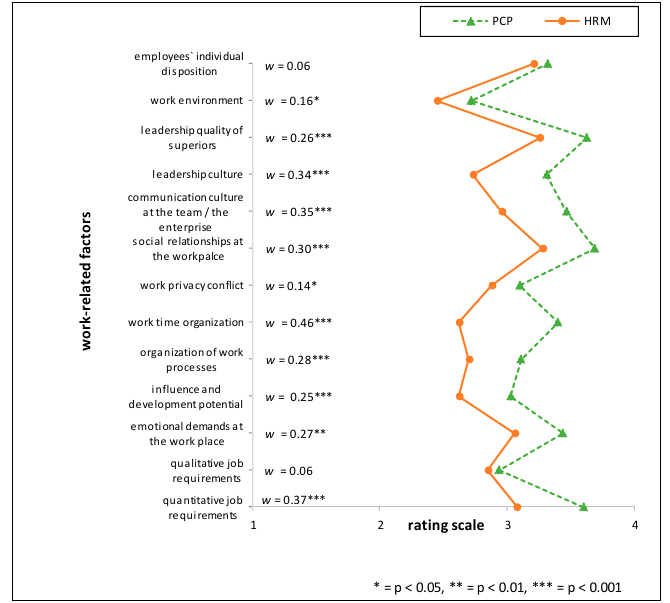
Figure 2. Polarity profile across work-related factors potentially important for (stress-associated) mental disorders in employees comparing the mean value ratings from “not at all important” (1) to “very important” (4) of Human Resource Managers (HRM) and Primary Care Physicians (PCP), w = effect size of differences.